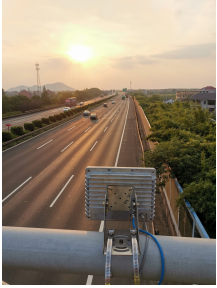
Figure 6. The experimental scene and the placement of the radar.